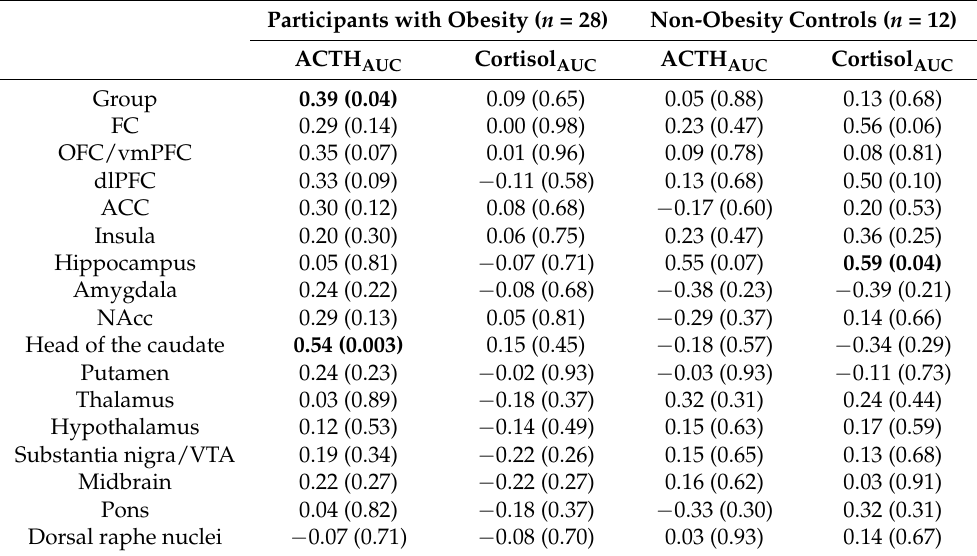
Table 3. Spearman correlations of dex/CRH test indicators and 5-HTT BP ND in the obesity group and non-obesity controls.